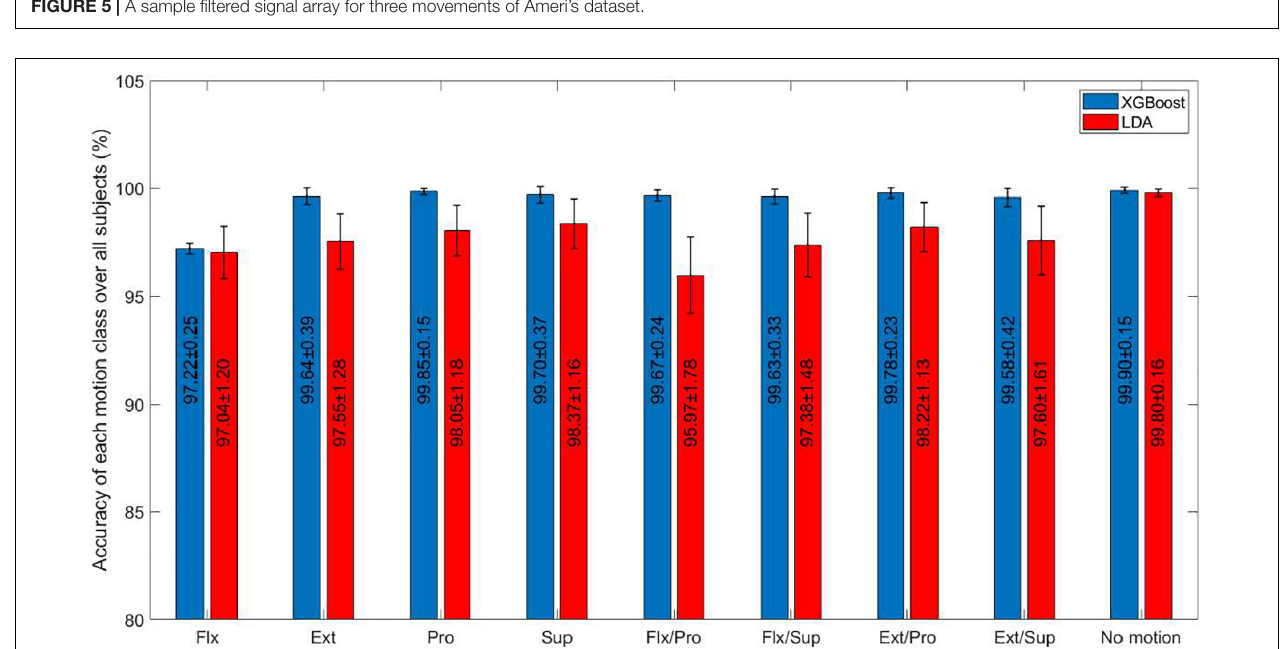
FIGURE 5 | A sample filtered signal array for three movements of Ameri’s dataset.